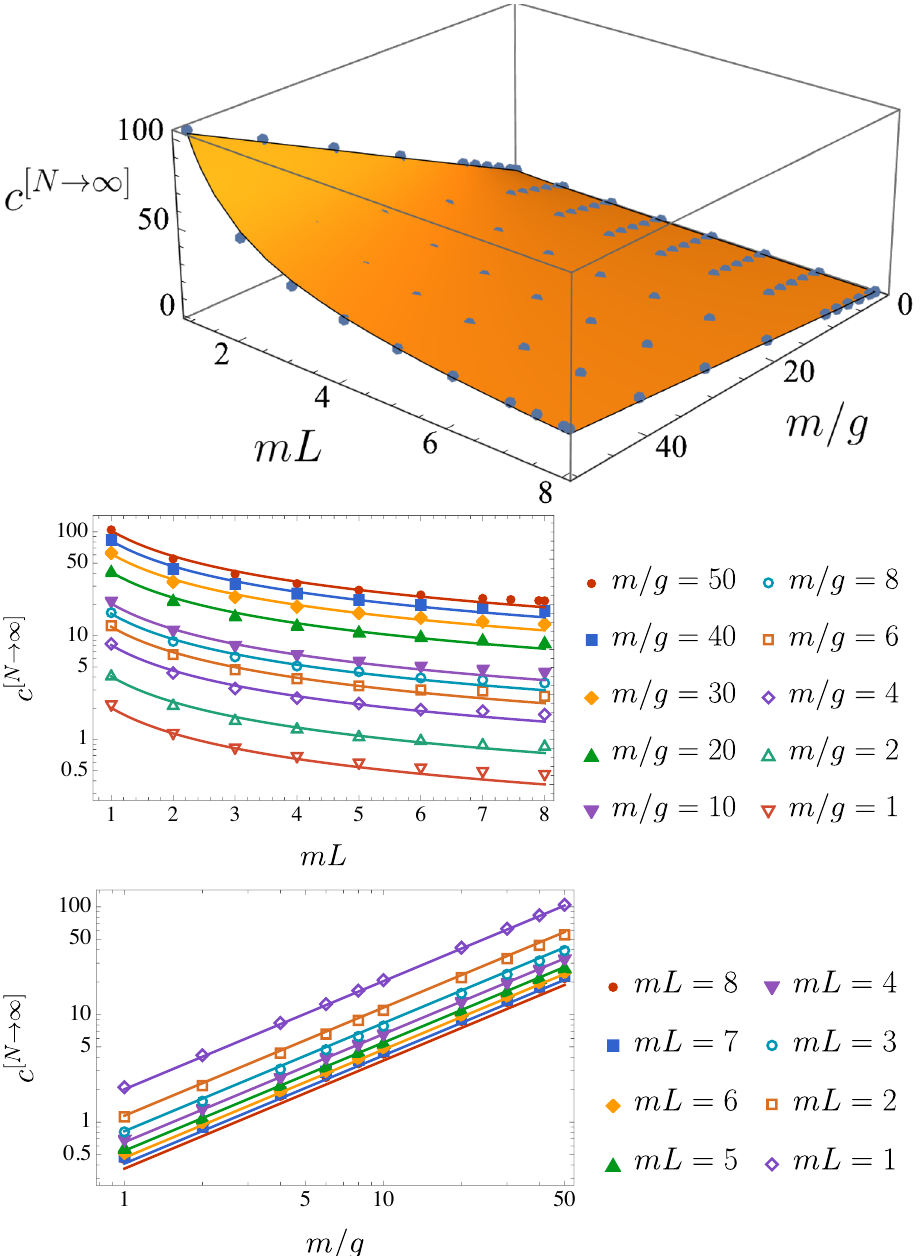
Figure 21. The continuum extrapolated prefactor c [ N →∞ ] as a function of m/g and mL . Top panel: the blue dots are the continuum extrapolated prefactors c [ N →∞ ] summarized in tables 4–7 while the orange surface is the function (C.2) with the best fit (C.3). Middle panel: the dependence of c [ N →∞ ] on mL for various fixed m/g values. Bottom panel: the dependence of c [ N →∞ ] on m/g for various fixed mL